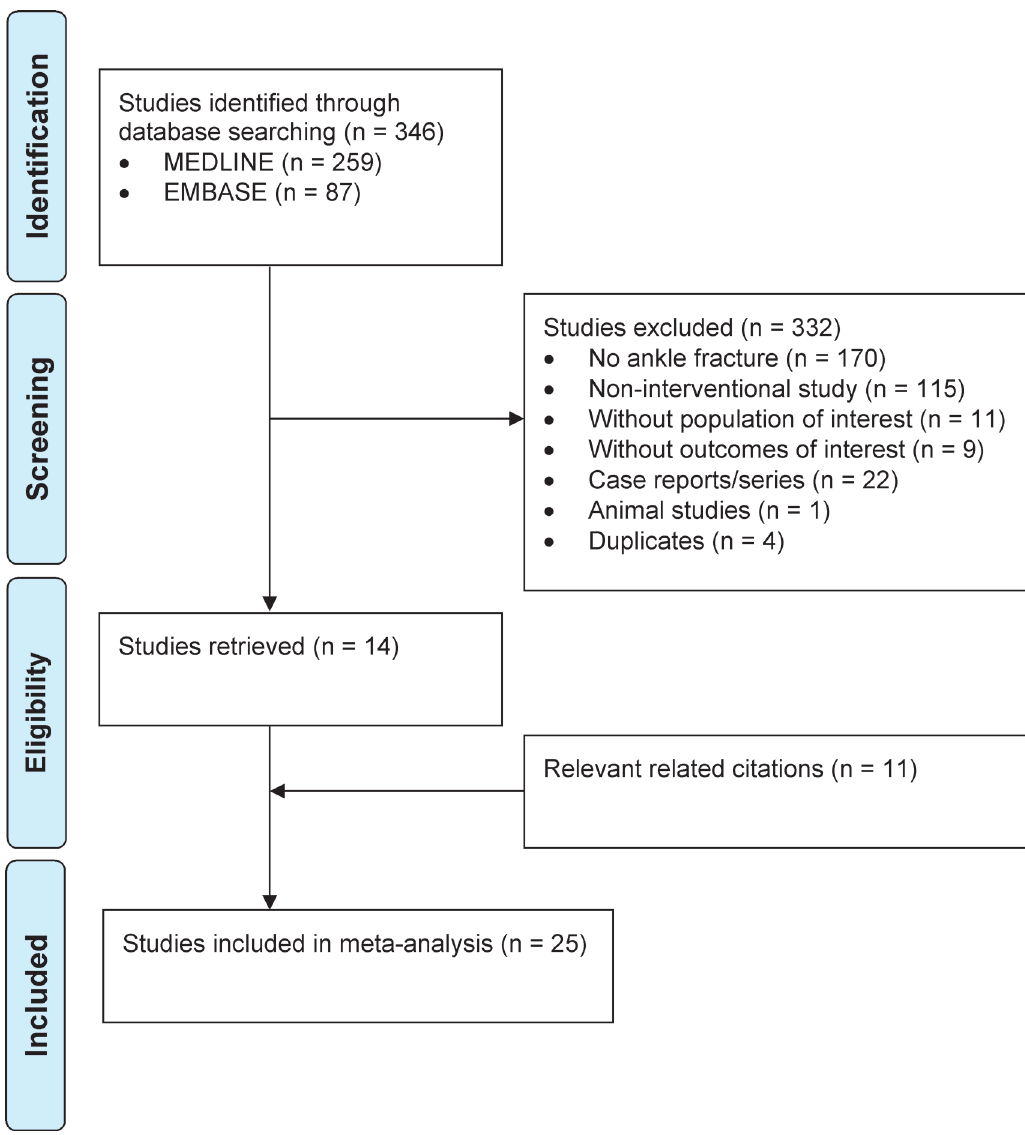
Fig 1. Process from initial search to final inclusion of studies on postoperative care of ankle fractures. A flowchart following the PRISMA guidelines of the search